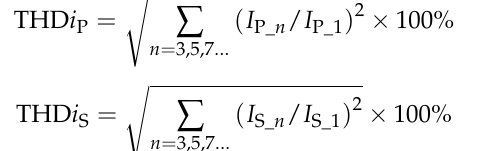
Figure 6. The relationship between phase shift ratio and THD i S with DPS modulation.